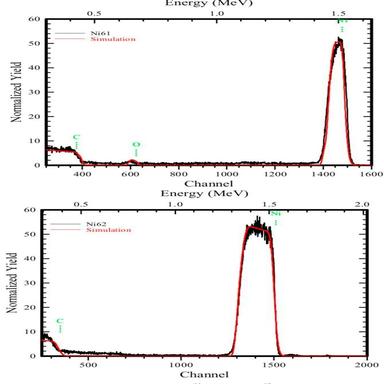
The RBS spectra of 61Ni(top) and 62Ni(bottom).